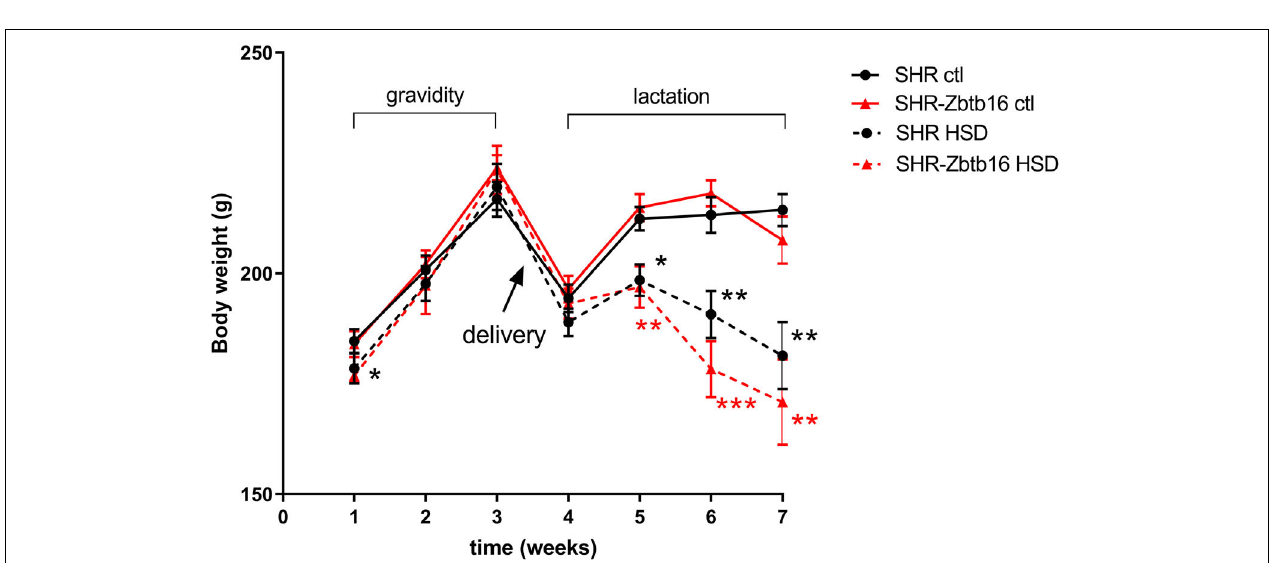
FIGURE 2 | Bodyweight measurements of SHR (black circles) and SHR- Zbtb16 (red triangles) adult female rats in gravidity (weeks 1–3) and lactation period (weeks 4–7): SHR control females (SHR ctl – full black line), SHR females fed HSD (SHR HSD – dashed black line), SHR- Zbtb16 control females (SHR- Zbtb16 ctl – full